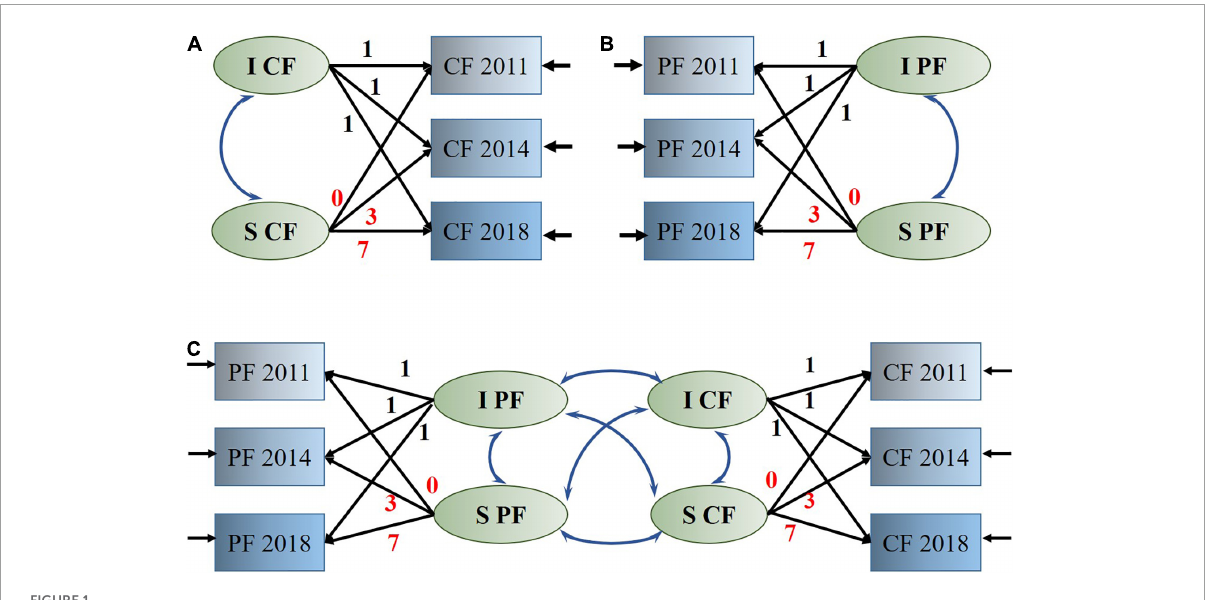
FIGURE1 Latent growth model. (A) Measurement of latent growth model for cognitive function. (B) Measurement of latent growth model for physical function. (C) Structural latent growth model to assess the relationships between changes in physical function and cognitive function. PF, physical function; CF, cognitive function; I, intercept; S, linear slope.